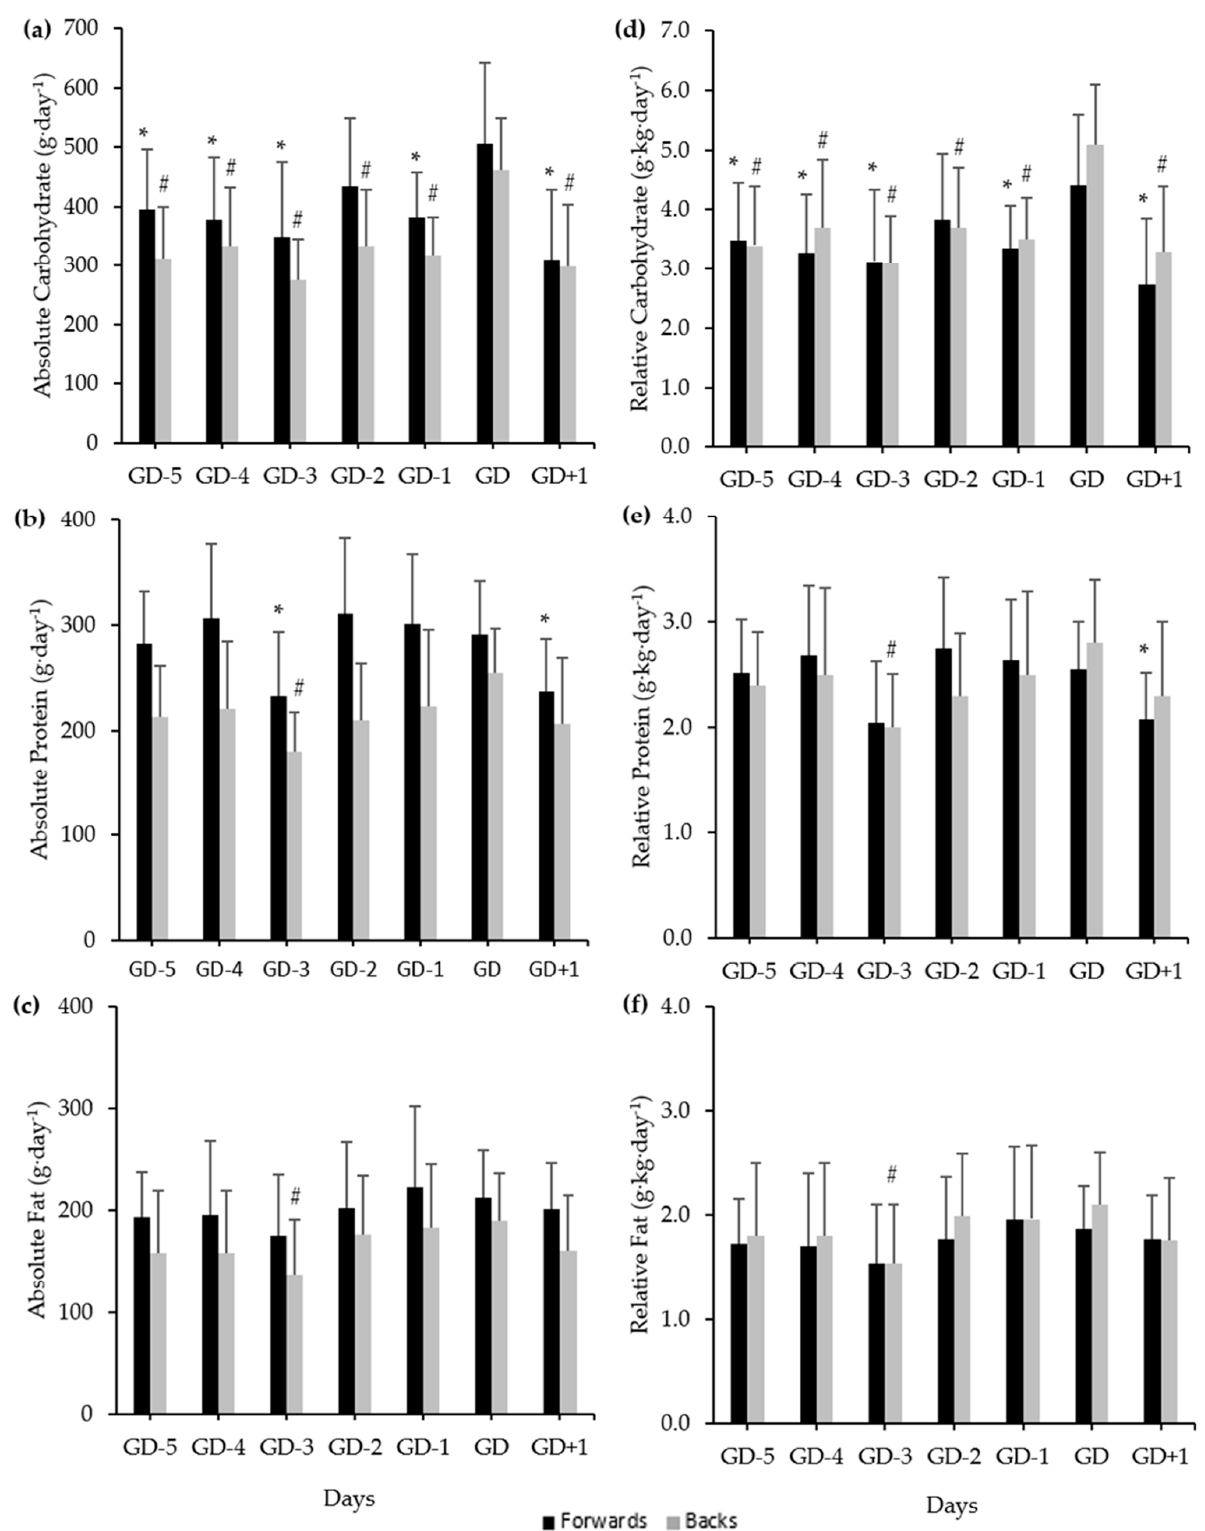
Figure 2. Mean daily macronutrient intake across a seven-day competition week (GD-5, -4, -3, -2, -1, GD, GD+1) among forwards and backs. ( a ) Absolute carbohydrate intake; ( b ) absolute protein intake; ( c ) absolute fat intake; ( d ) relative carbohydrate intake; ( e ) relative protein intake; ( f ) relative fat intake. Error bars represent standard deviation. * Indicates a significant difference to GD for forwards ( p < 0.05). # Indicates a significant difference to GD for backs ( p < 0.05).